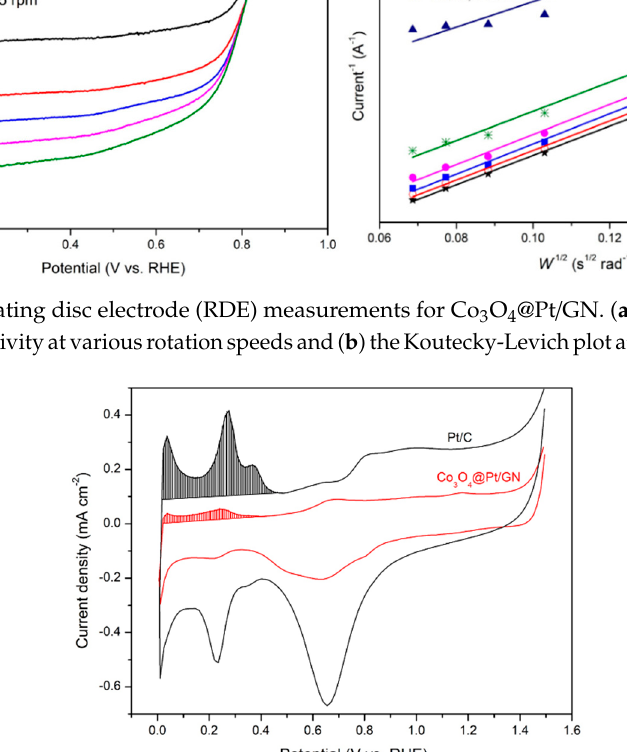
Figure 9. The cyclic voltammetric (CV) profiles for electrochemical active surface area (ECSA) measurements of Co 3 O 4 @Pt/GN and Pt/C.